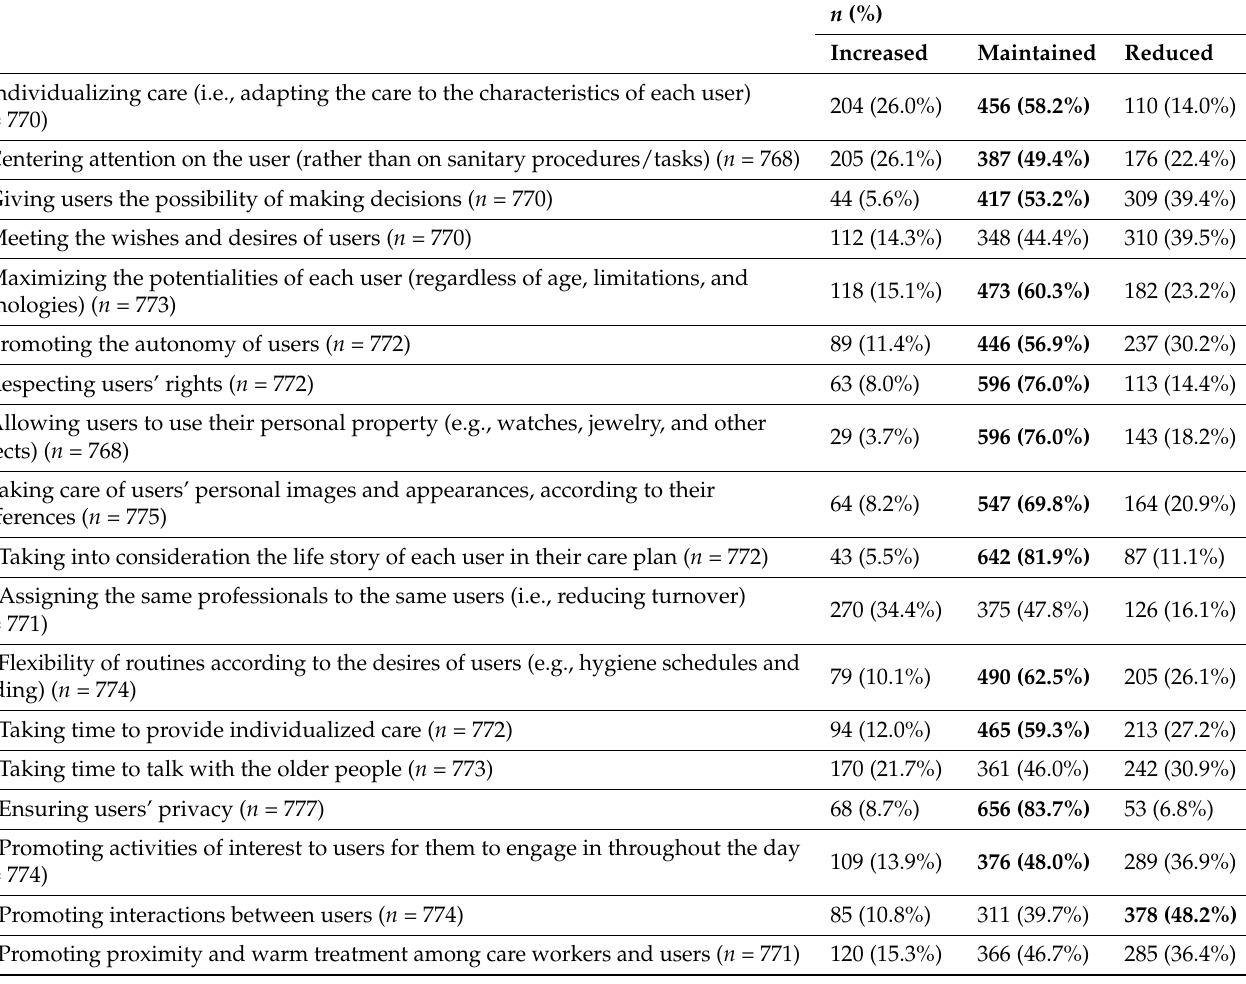
Table 2. Possibility of promoting PCC practices during the first wave of the pandemic (compared to before the pandemic).